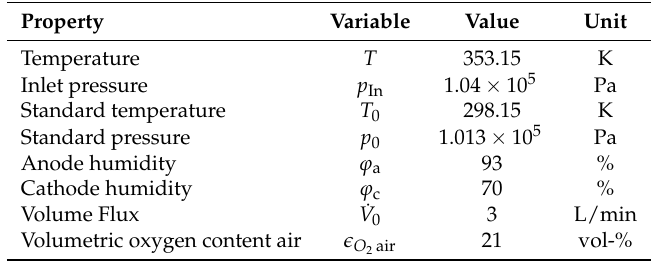
Table A3. Operating conditions used in the final simulation model.